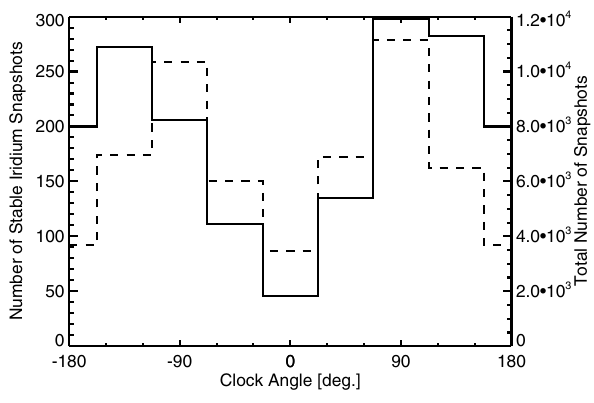
Fig. 4. Comparison of the IMF clock angle distribution from 1999 to 2005 (dashed line, right hand scale) with that of the 1,550 stable two-hour Iridium events used for this study (solid line, left hand scale).